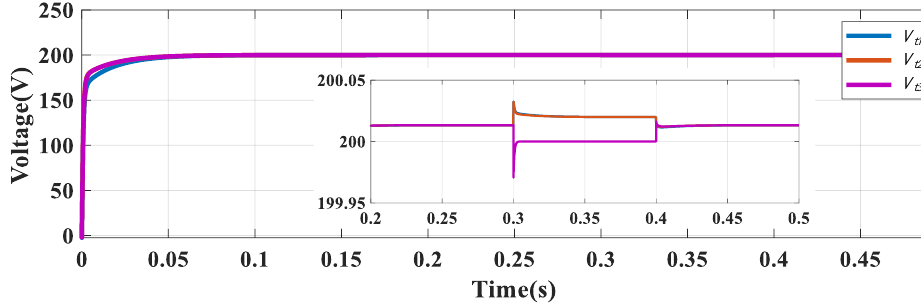
Figure 20. Study 3: output voltage of each DG.